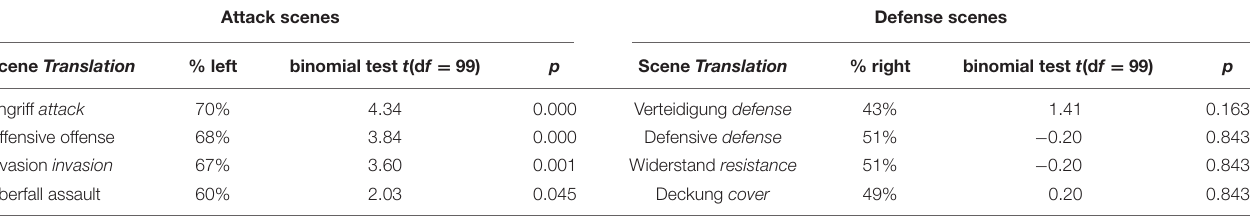
TABLE A1 | Positioning within attack and defense scenes in Study 1.